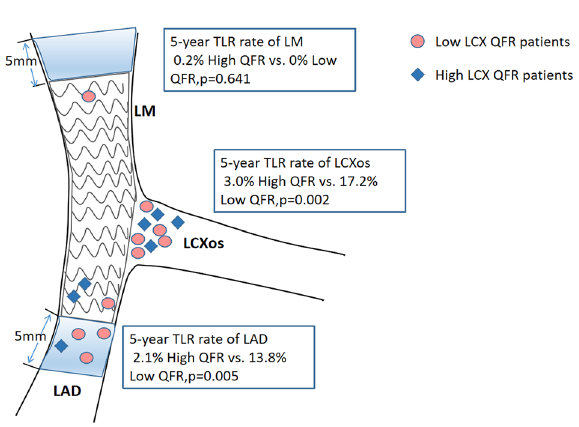
Figure 2. 5-Year event rate according to QFR in jailed LCx after LM simple crossover stenting. Comparison of estimated event rates including: ( A ) target lesion failure, ( B ) target lesion revascularization of LCXos, ( C ) MACE, ( D ) death or myocardial infarction between the high QFR group (continuous line) and the low QFR group (dotted line).